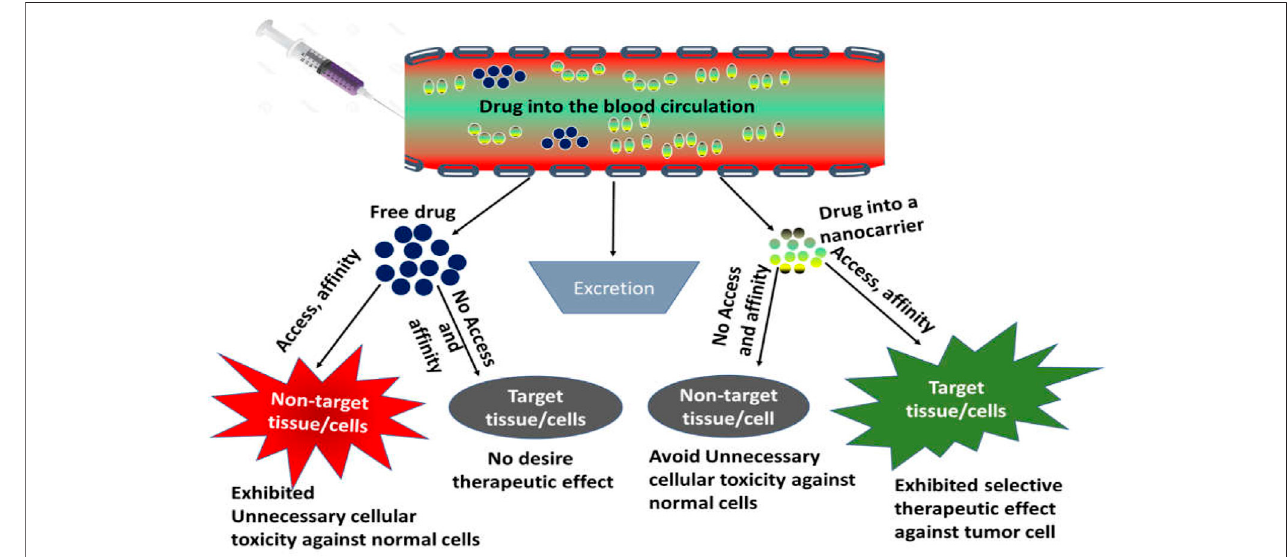
FIGURE 2 | Basic principle of drug